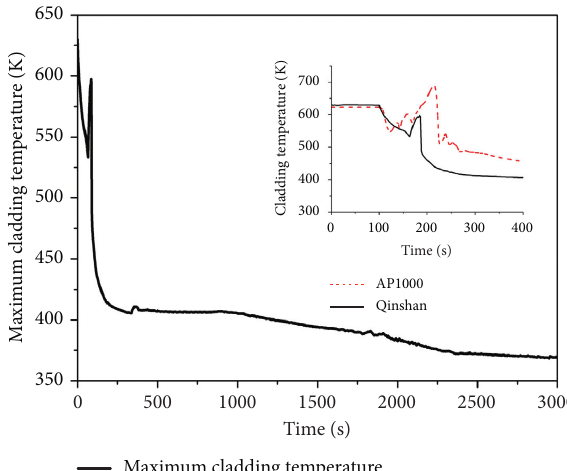
Figure 9: 10-inch CL break reactor core water level.